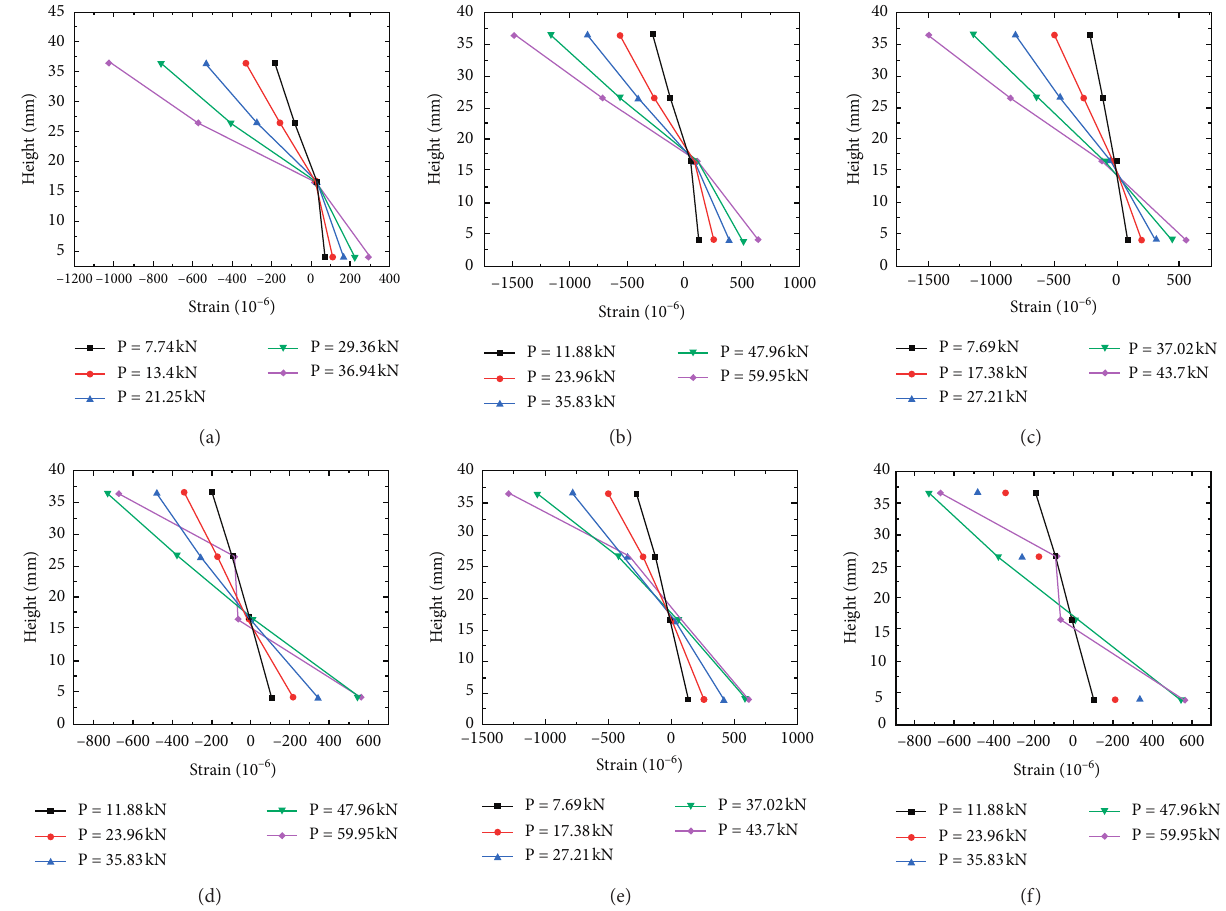
Figure 10: Strain distribution at the mid-span section of specimens. (a) CD-ER-P- λ ERG-P- λ 3.33 . (e) CD-ERA-P- λ 4.44 . (f) CD-ERA-P- λ 3.33